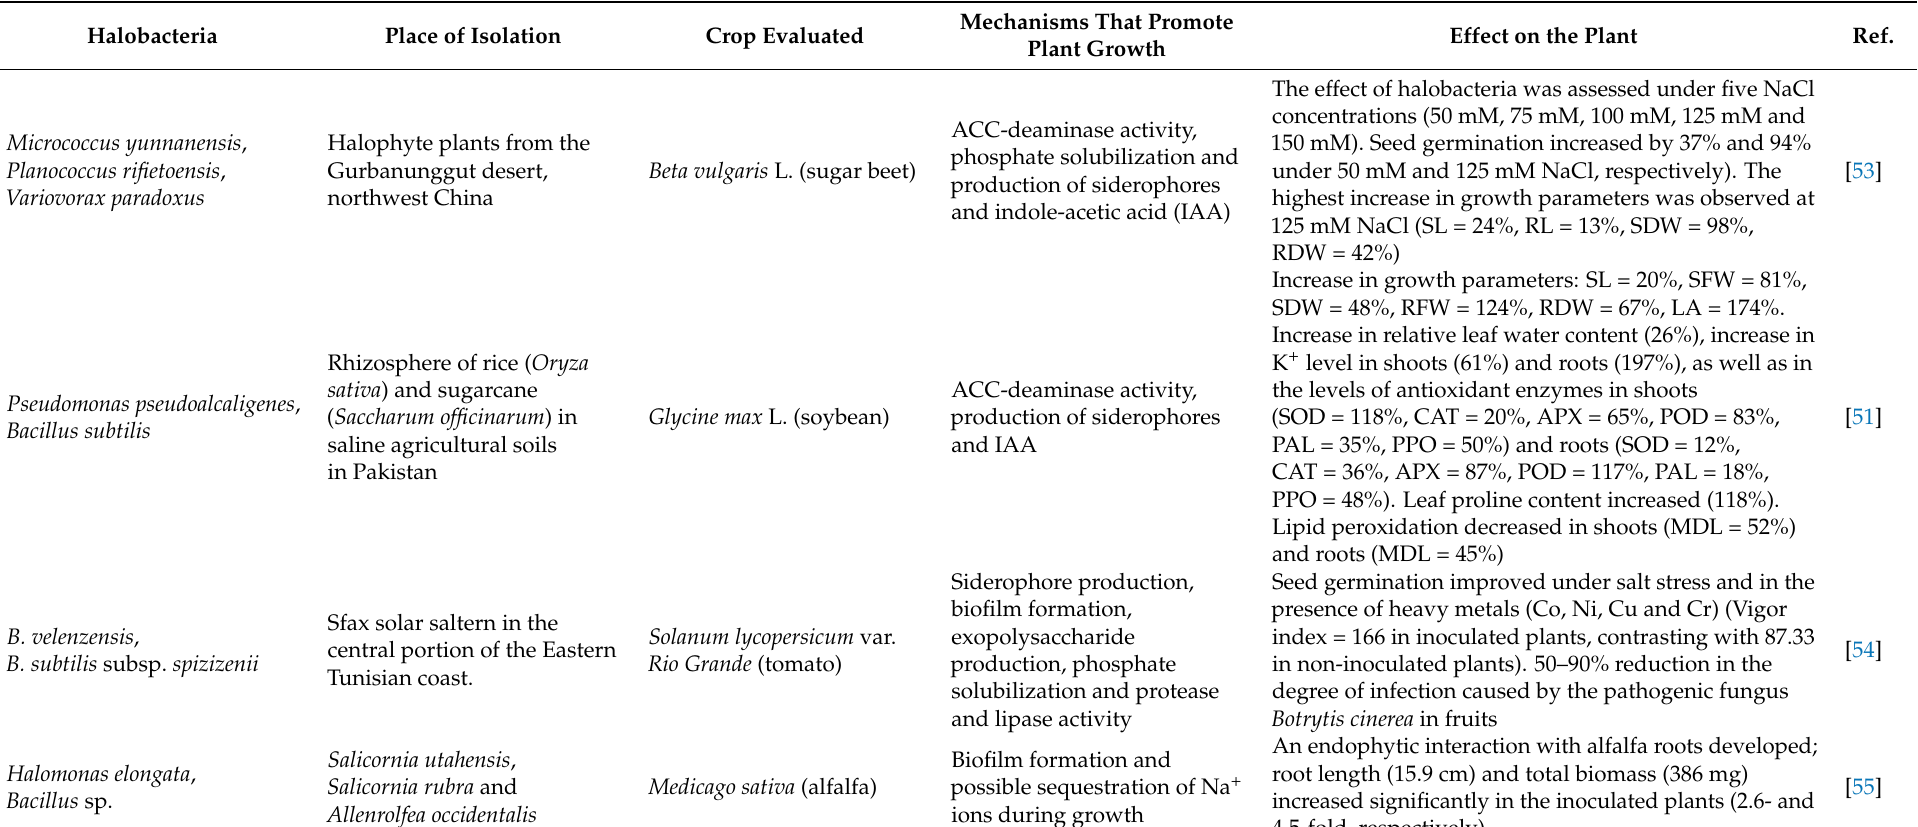
Table 1. Effect of plant growth-promoting halobacteria in different crops under salt